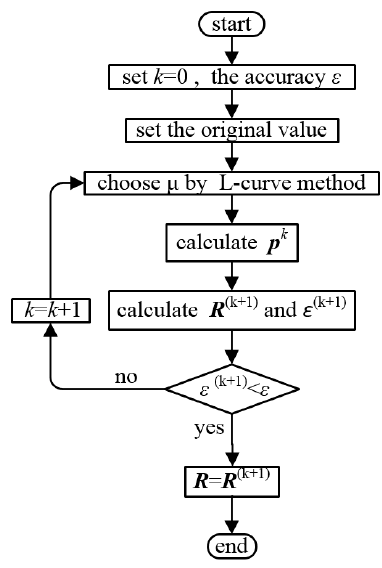
Figure 3. The calculation flow chart.